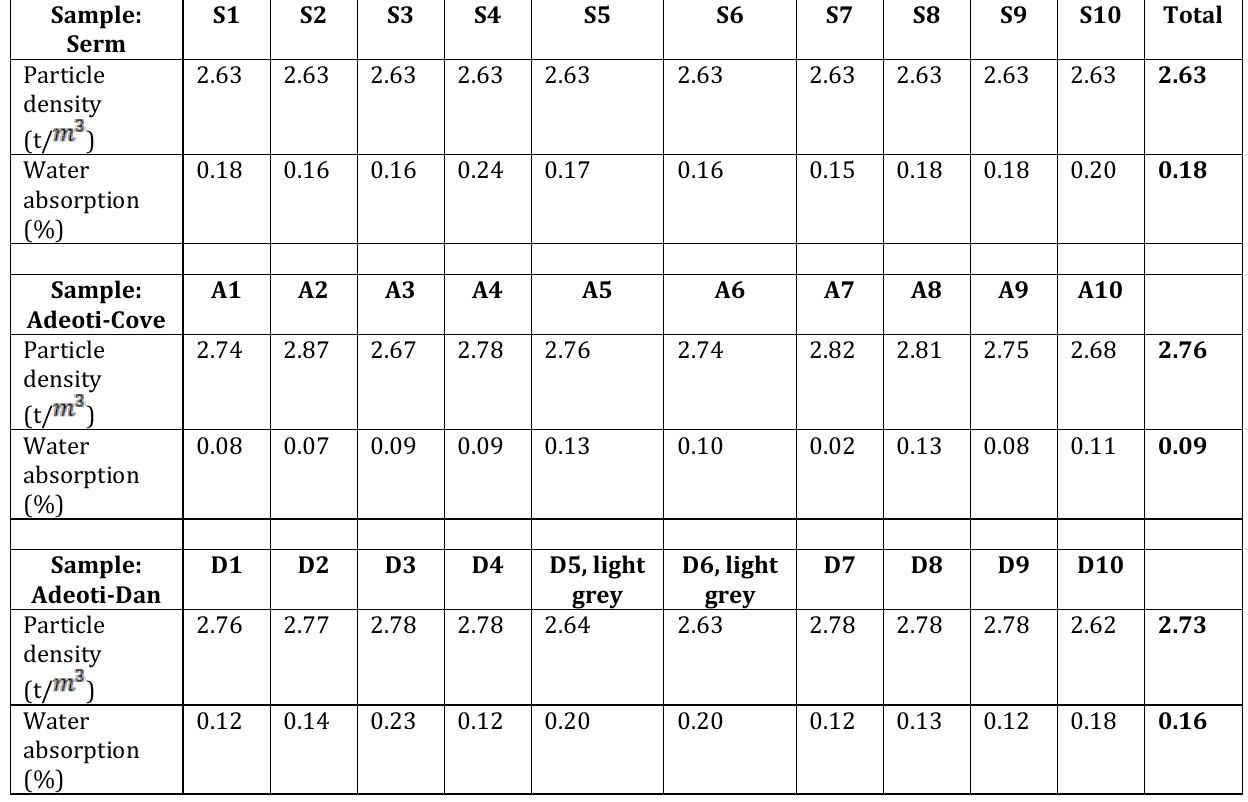
Table 2. Test results for particle density and water absorption Sample: